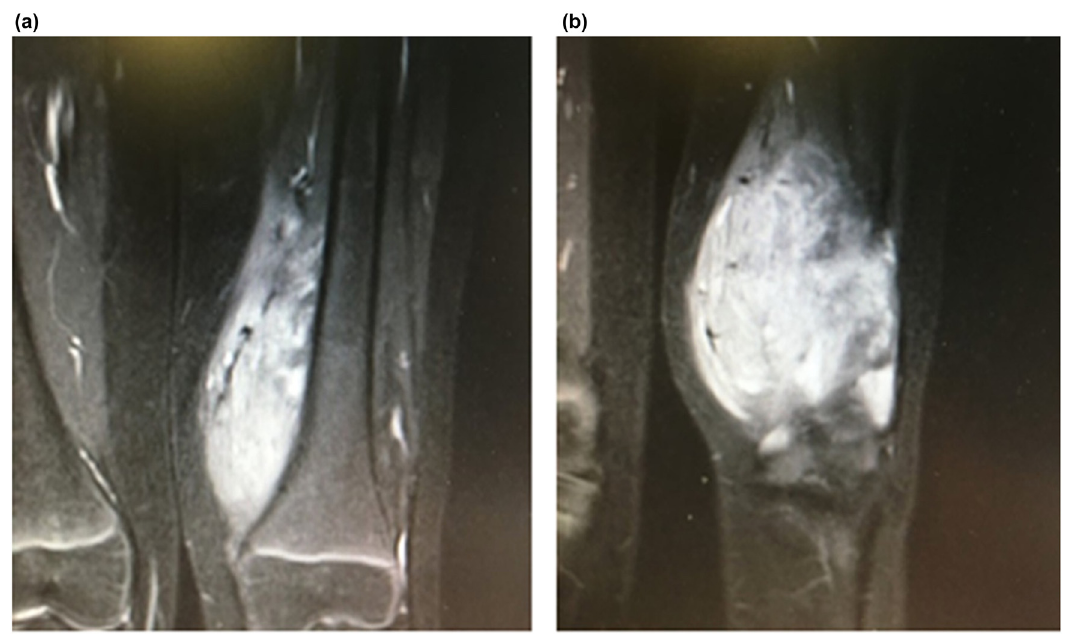
Figure 2: Preoperative magnetic resonance imaging. ( a ) Focal mass - like FAVA, which produced progressive thigh pain over the last year; ( b ) the sagittal image shows maximal mass hyperintensity in T2 - weighted